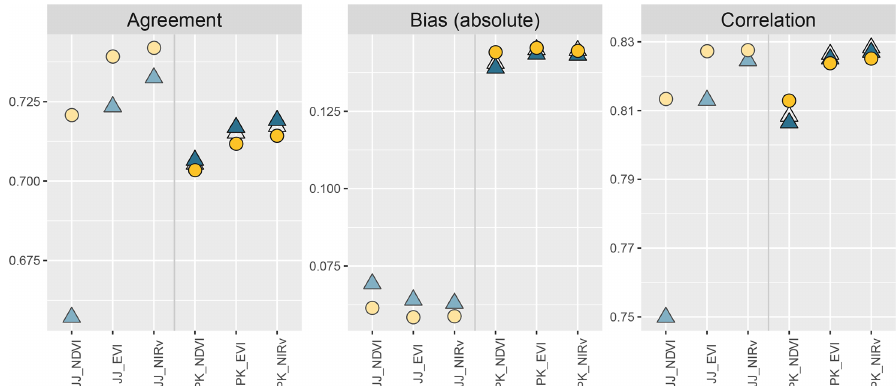
Figure 1. Exploring the agreement, absolute bias and correlation between the OCO-2 validation dataset and downscaled GOME-2 SIF based on different retrievals (PK for Köhler et al., 2015, or JJ for Joiner et al., 2013) and using different explanatory variables (NDVI, EVI or NIRv for V ). Not all combinations were calculated. Yellow circles indicate the use of ET as a proxy for hydric stress ( W ), while triangles represent the use of NDWI instead. Empty triangles correspond to a subset in which the proxy for thermal stress ( T ) is changed from MYD to MOD (this was only done for the PK dataset). Each metric is calculated based on all available samples within the period